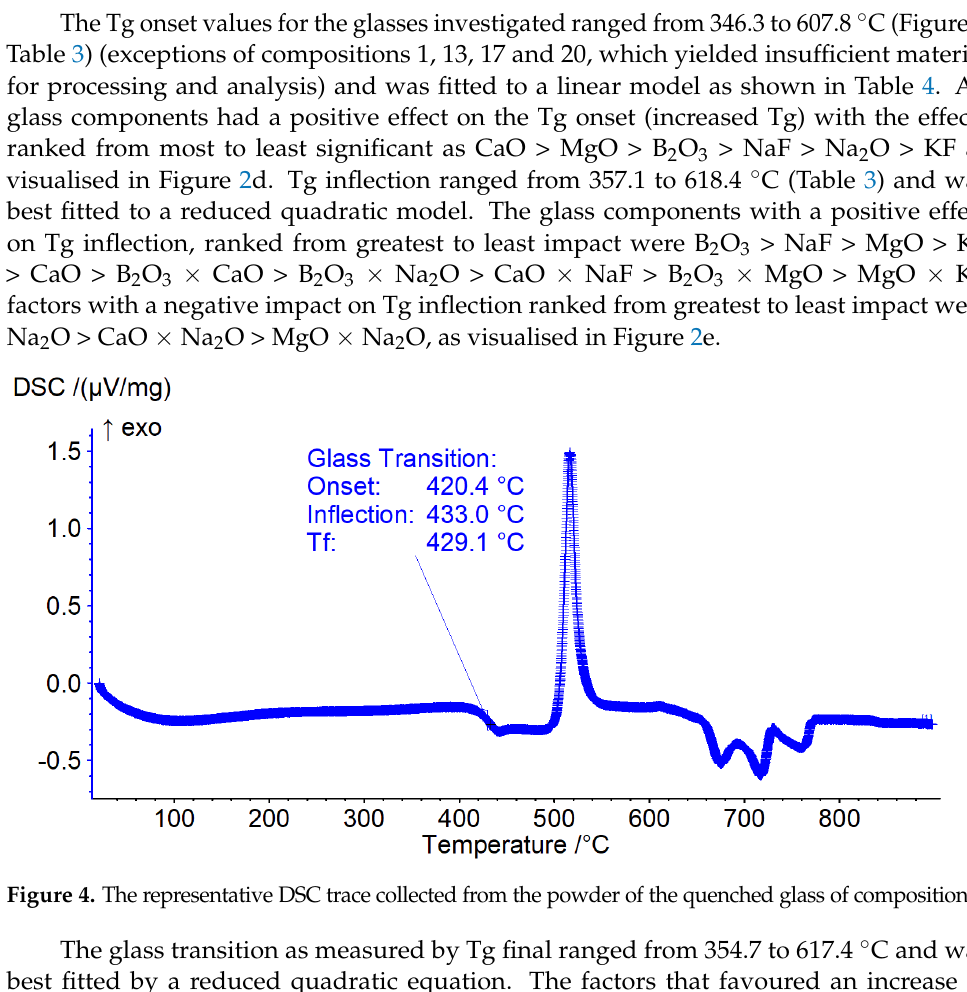
Figure 2c. To better visualise overall impact of glass components, a graphical correlation table is presented in Figure 3.